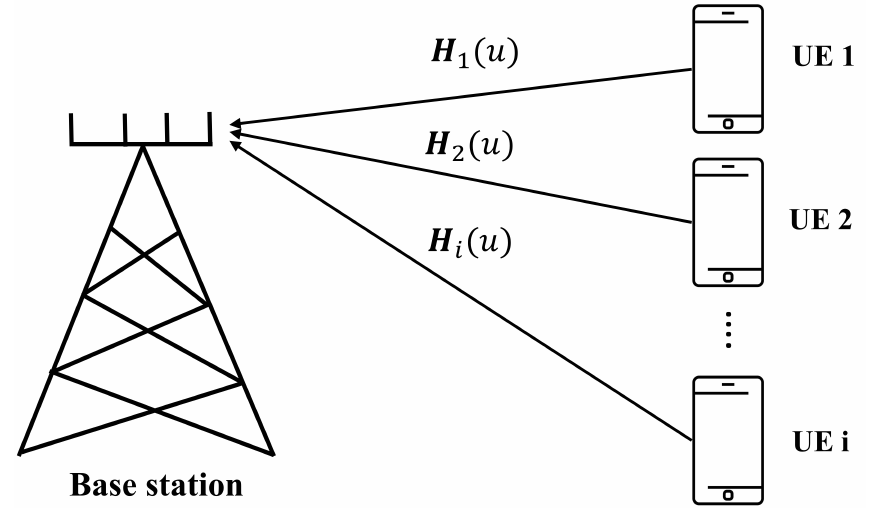
Figure 1. Uplink multiuser communication system with